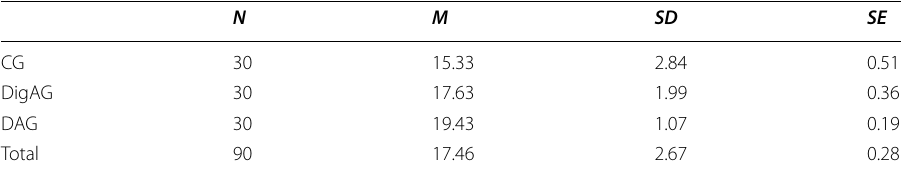
Table 8 Descriptive statistics of speaking accuracy posttest of all groups N M SD SE CG